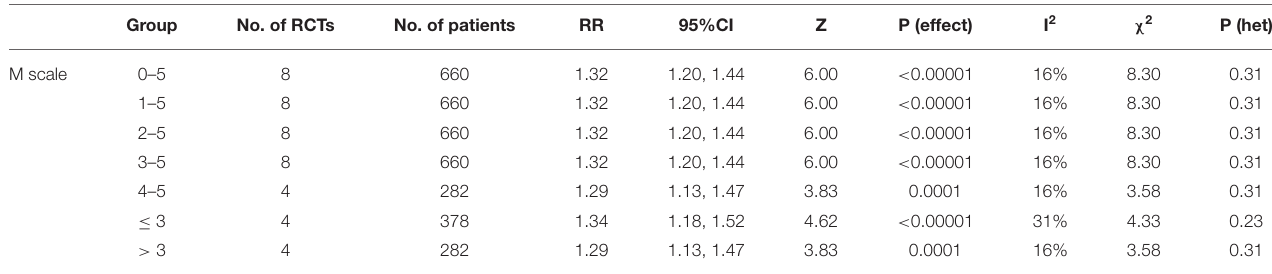
TABLE 4 | Sensitivity analysis based on the outcome measure